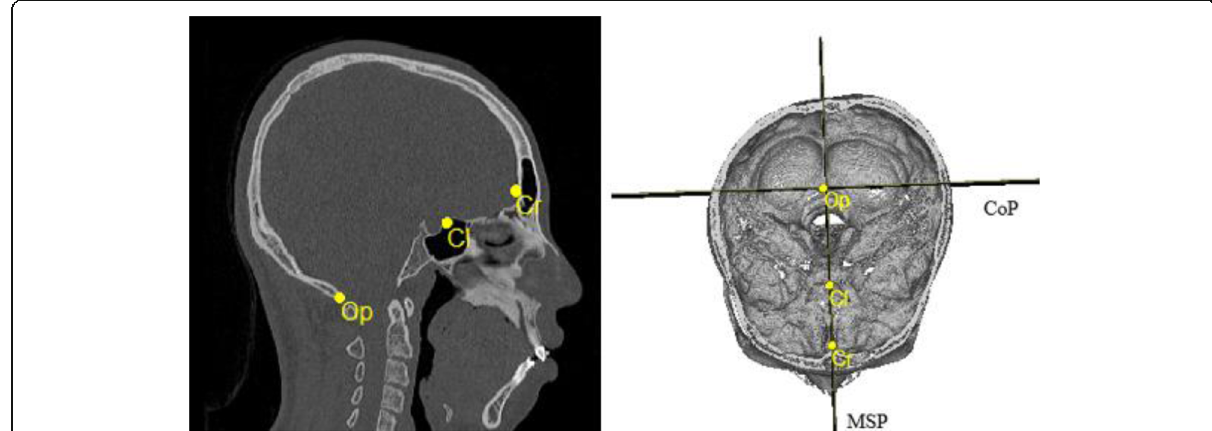
Fig. 2 Computed tomography (CT) scans of craniofacial landmarks. Cr, crista galli; Cl, clinoid process; Op, opisthion; MSP, midsagittal plane; CoP, coronal